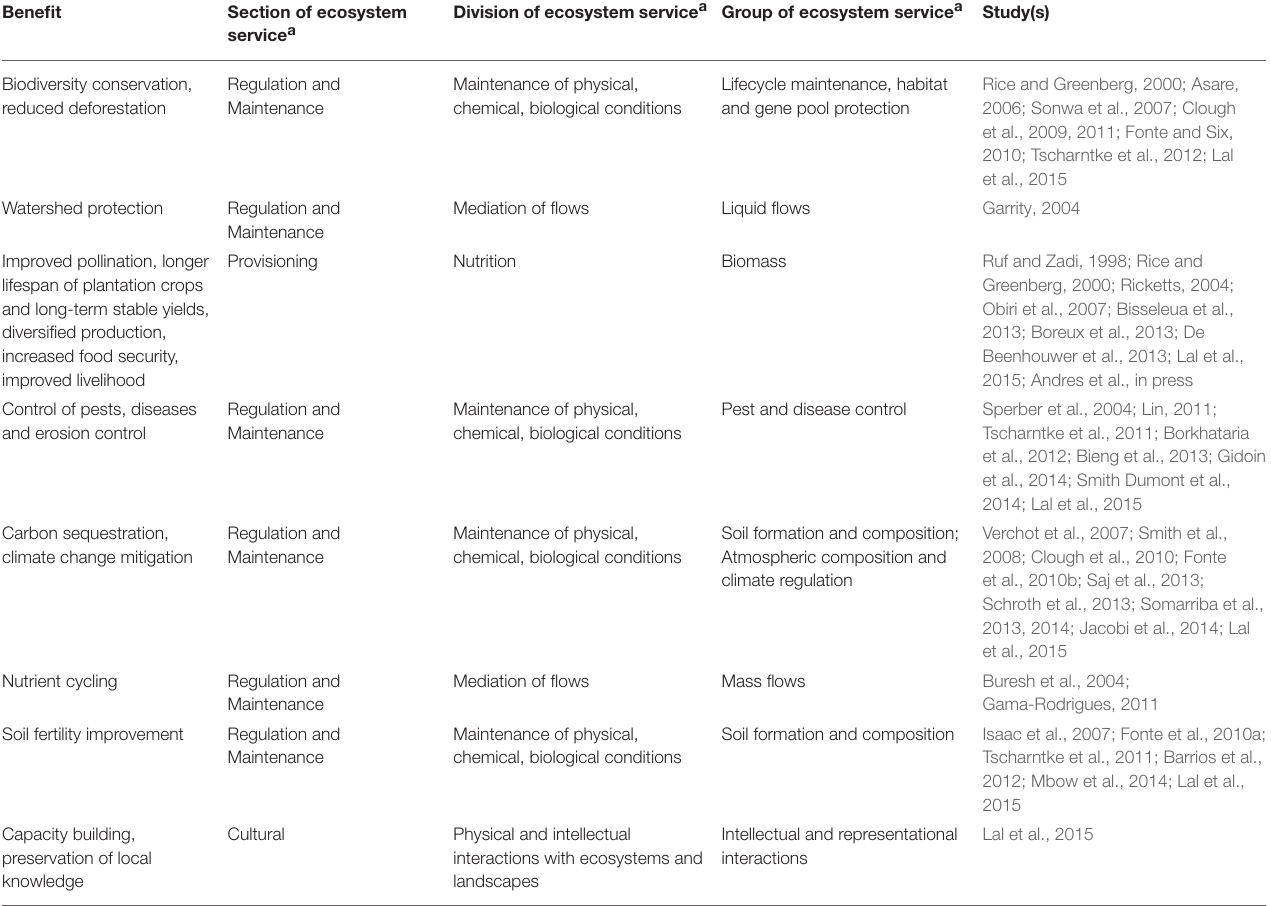
TABLE 1 | Benefits provided by agroforestry systems reported in the